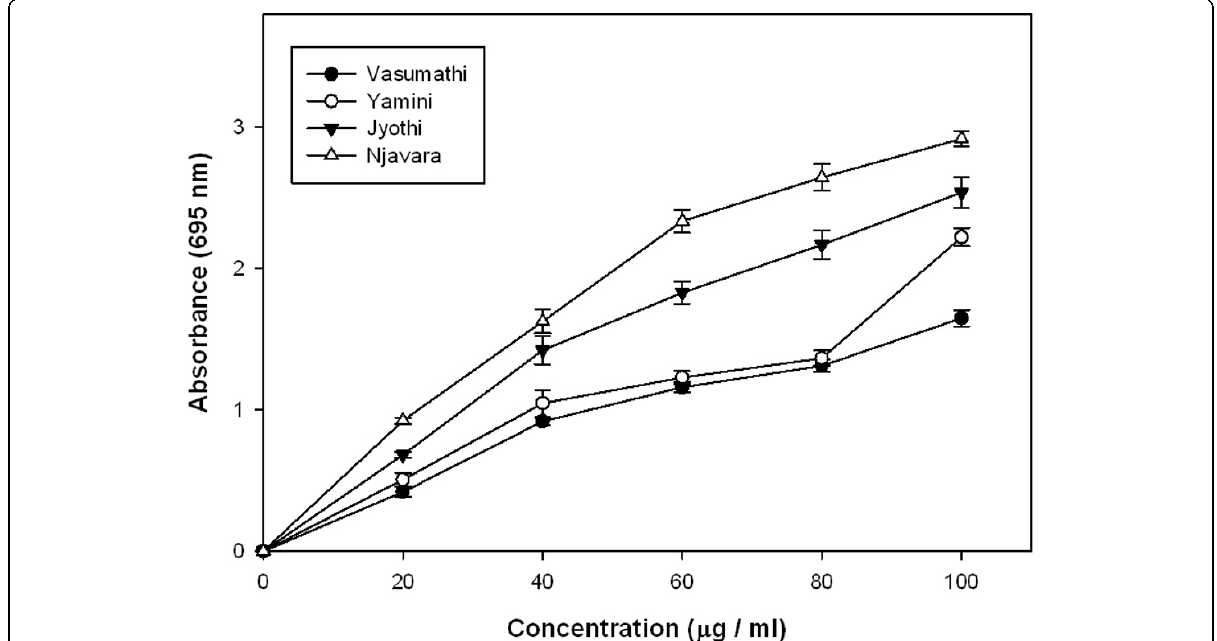
Figure 1 Total antioxidant activity . TAA carried out with different concentrations of methanolic rice bran extracts from four rice varieties. Results represent means ± standard deviation (n =